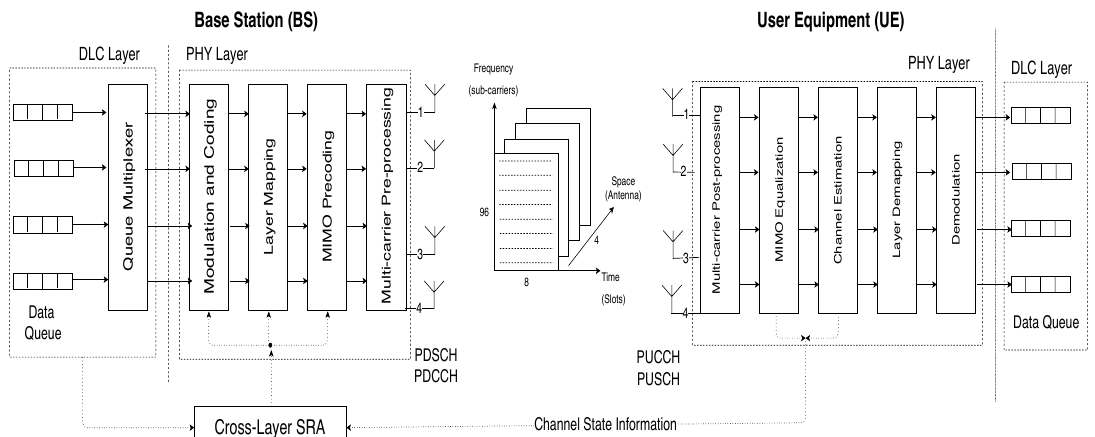
Figure 2. System architecture. DLC, Data Link Control; PDSCH (Physical Downlink Shared Channel); PDCCH (Physical Downlink Control Channel); PUCCH (Physical Uplink Control Channel); PUSCH (Physical Uplink Shared